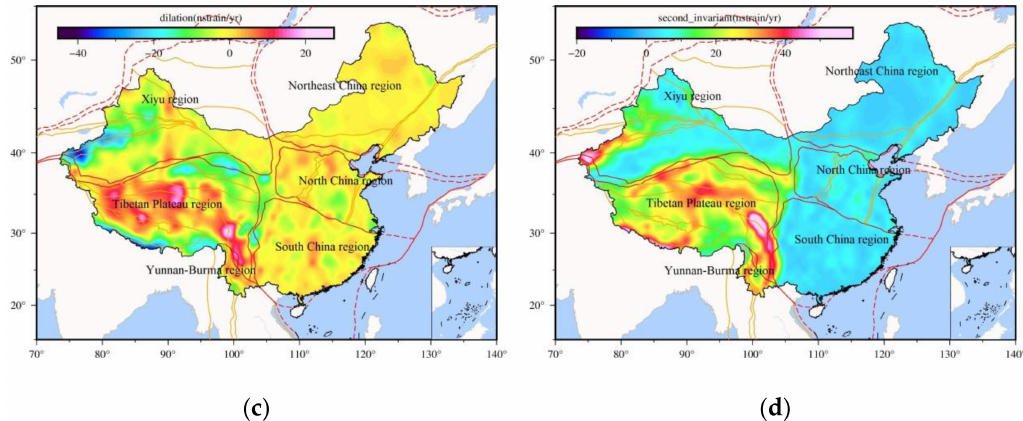
Figure 8. Other strain rate fields (( a ): maximum shear strain, ( b ): rotation, ( c ): surface expansion, ( d ): second strain